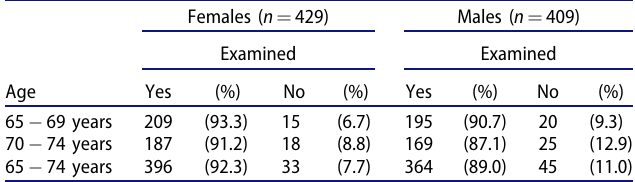
Table 2. Participation in the population survey in Tierp, by age and gender.